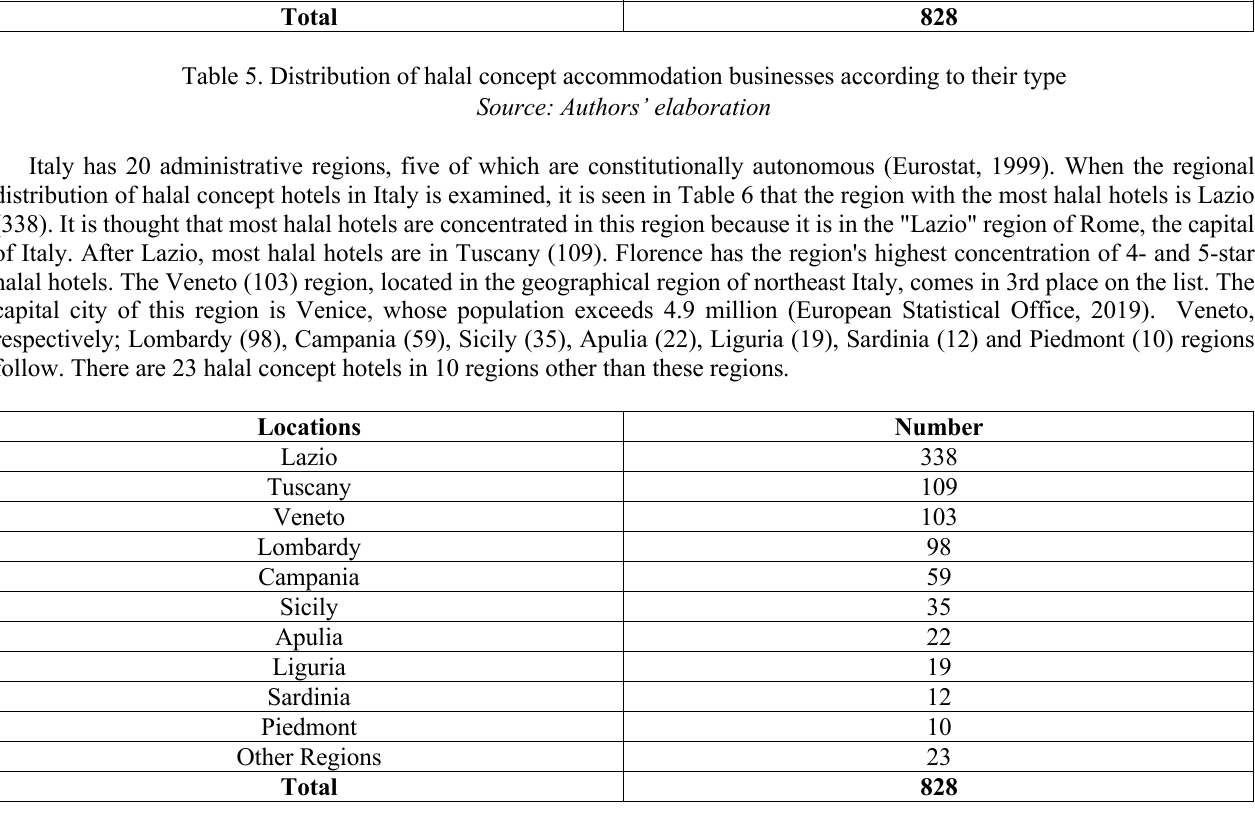
Table 6. Regional distribution of halal concept hotels in Italy Source: Authors’